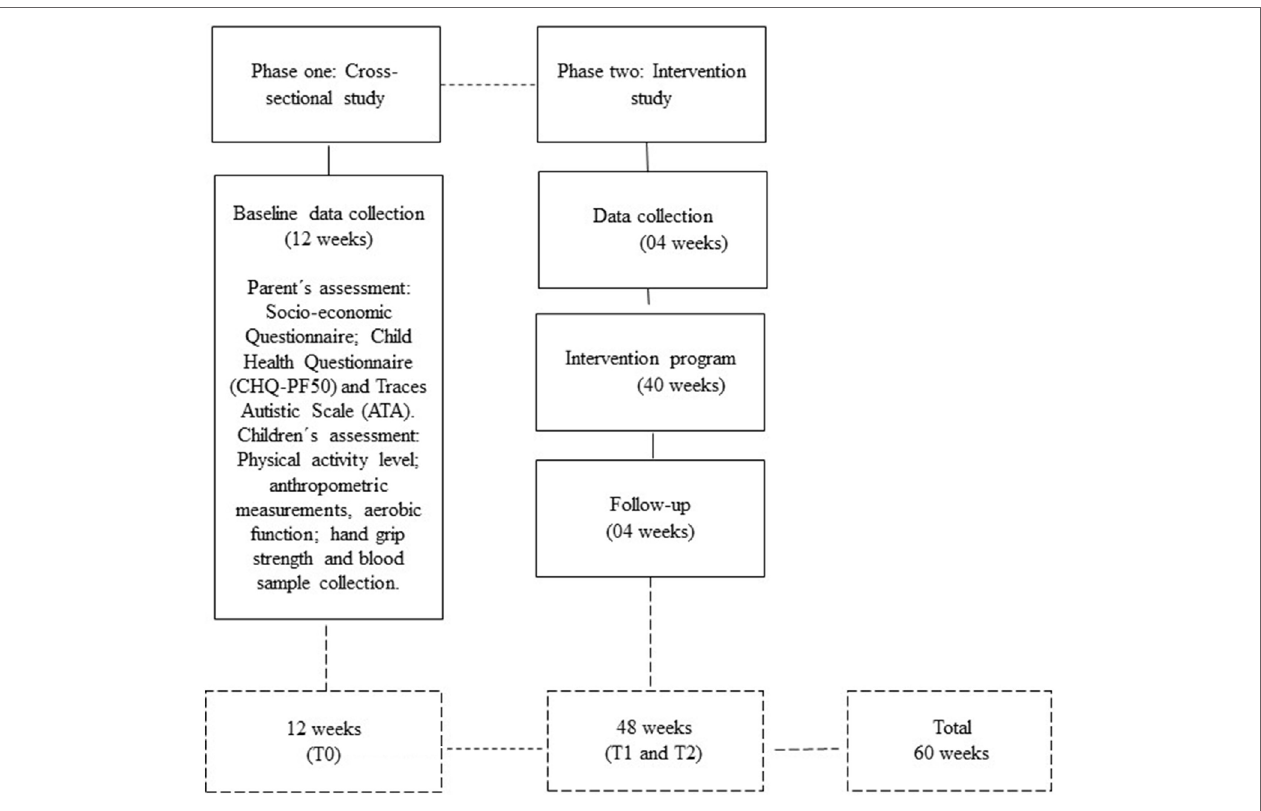
FIGUrE 1 | Timeline of the PEP-Aut’s phases (cross-sectional and